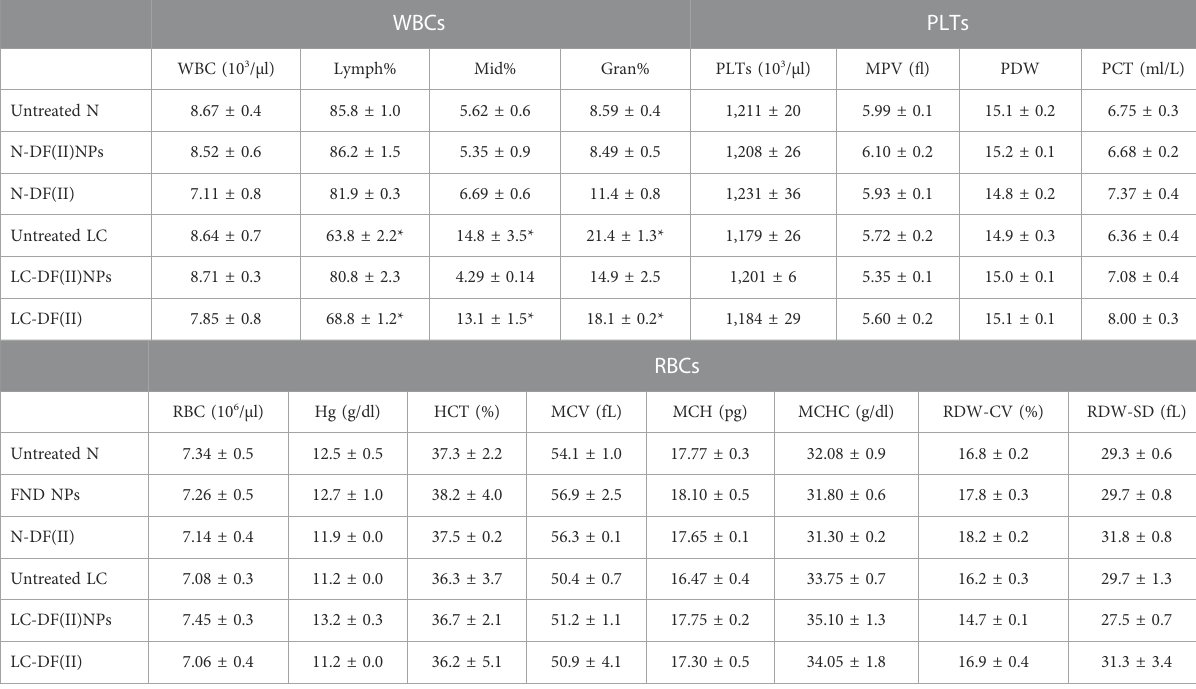
TABLE 1 Hematological (WBCs, platelets, and RBCs)